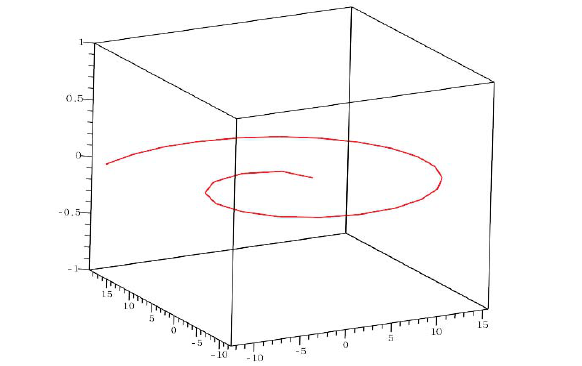
Figure 1. The plane curve in Example 1.